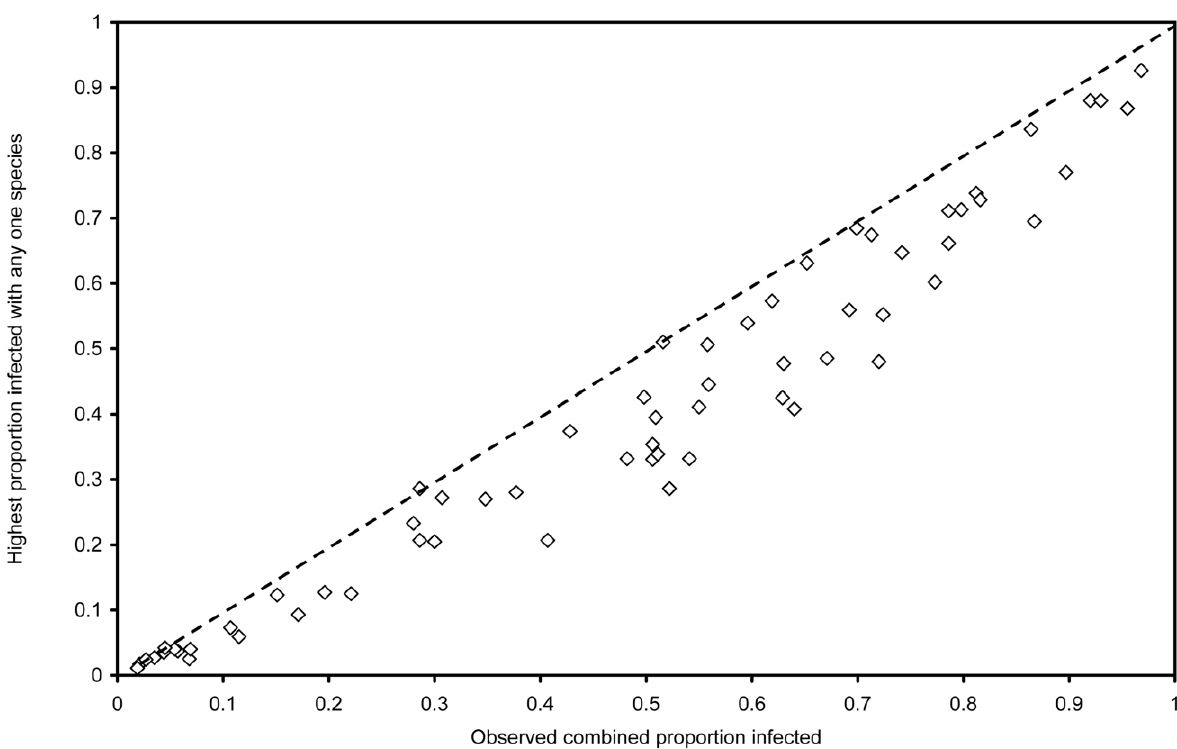
Figure 4. A scatter plot of the observed combined proportion infected with intestinal nematode worms against the proportion infected with the most common species.